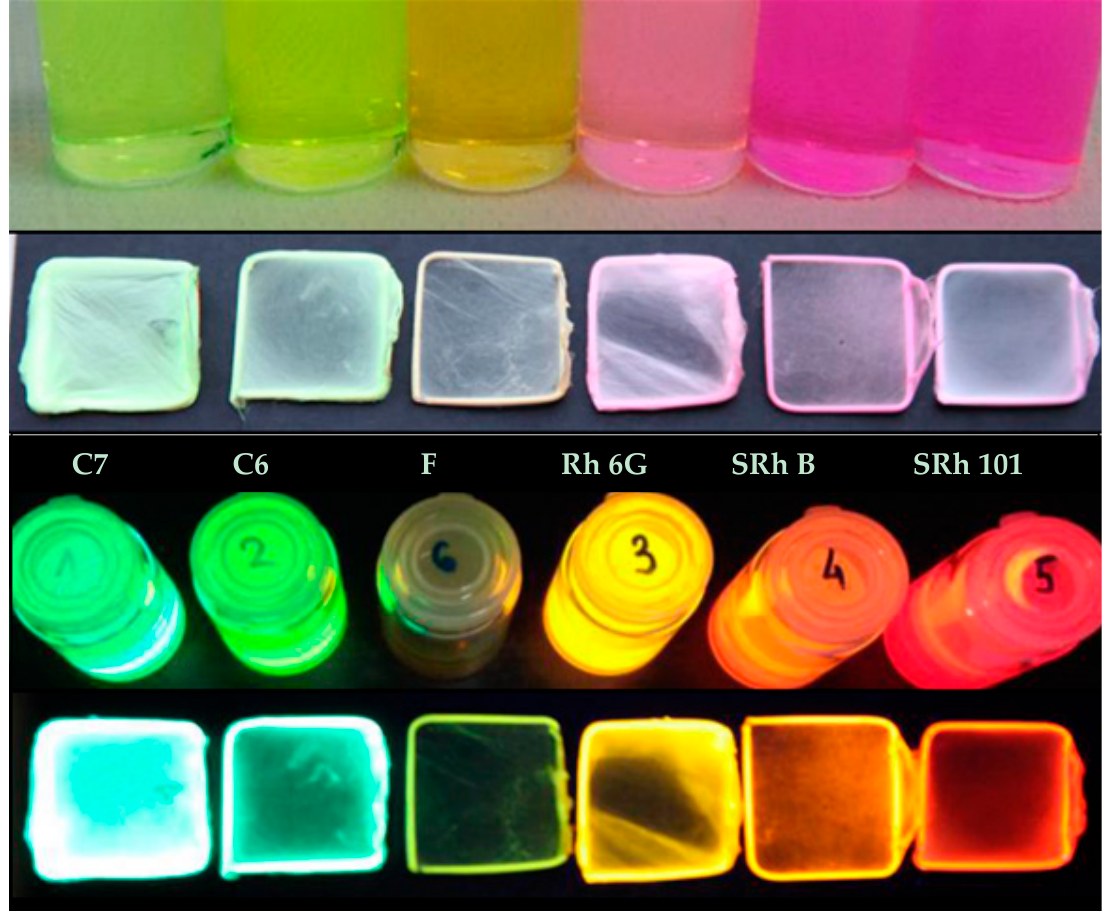
Figure 2. Images of the polymer solutions and the corresponding electrospun submicronic fiber mats collected on copper frames in visible light ( upper ) and UV light ( lower ).